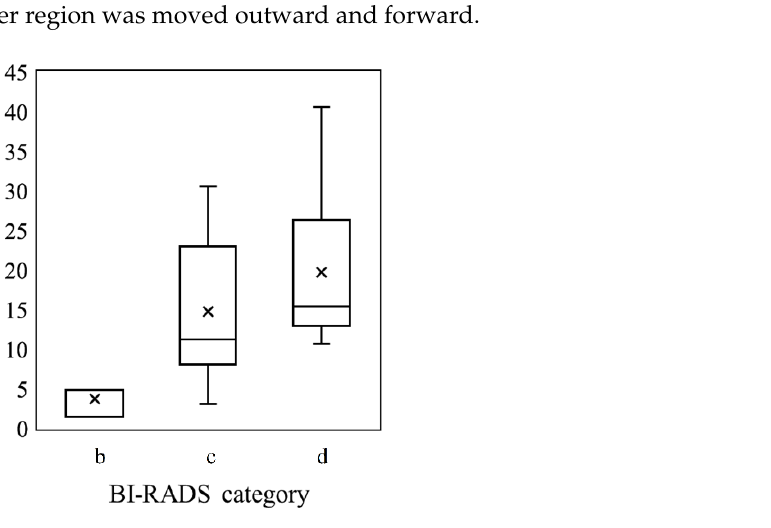
Figure 4. Box plot of VBD for b, c, and d BI-RADS categories. The horizontal line in the box represents the median, and the box contains the 25–75 percentiles. No cases of BI-RADS category a were recorded in this study.